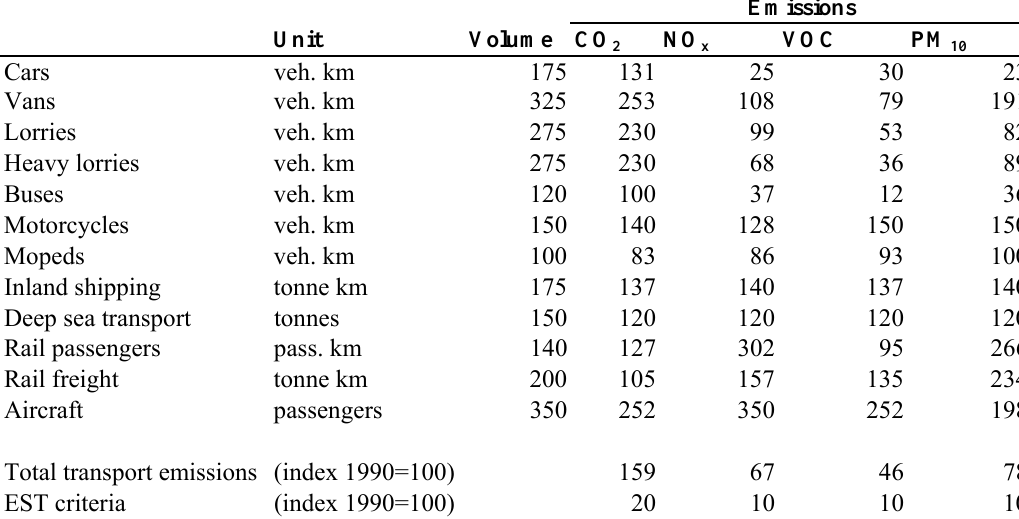
Table 2: Vehicle use and emissions in 2030 - business-as-usual scenario (index 1990 =